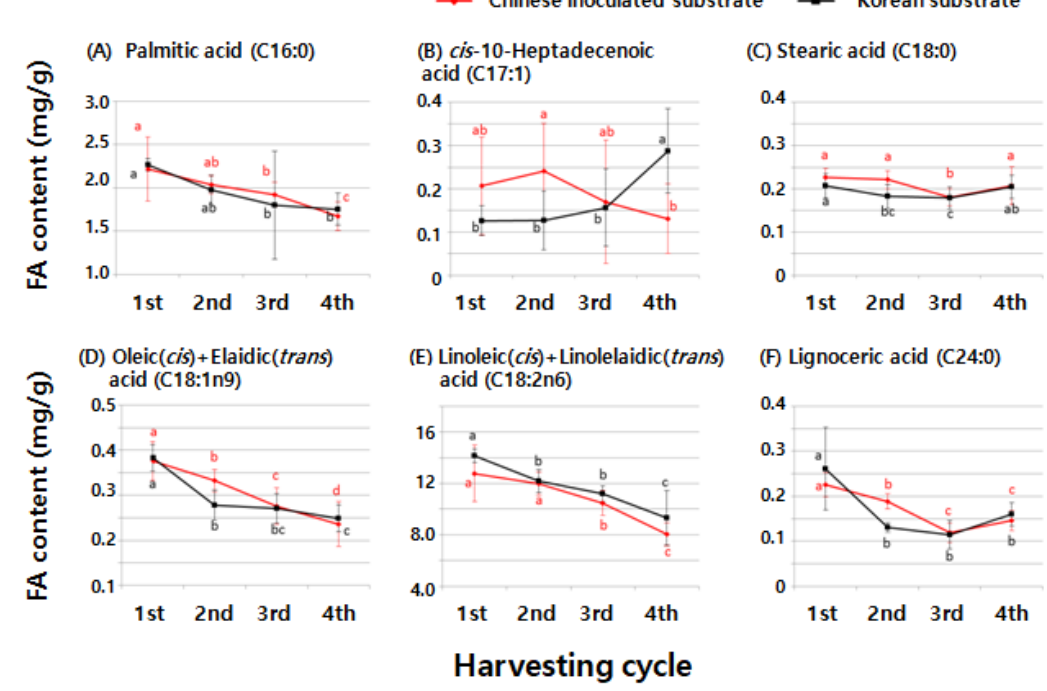
Figure 4. Comparison of the FA levels in shiitake mushrooms cultivated using Chinese and Korean substrates according to the harvesting cycle. ( A ) Palmitic acid (C16:0), 18: 19, 20: ( B ) cis -10-heptadecenoic acid (C17:1), ( C ) stearic acid (C18:0), ( D ) oleic ( cis ) and elaidic ( trans ) acid (C18:1 n -9), ( E ) linoleic ( cis ) and linolelaidic ( trans ) acid (C18:2 n -6), and ( F ) lignoceric acid (C24:0). a – c Values with different superscripts differ significantly with respect to the harvesting cycles of shiitake produced by each substrate.